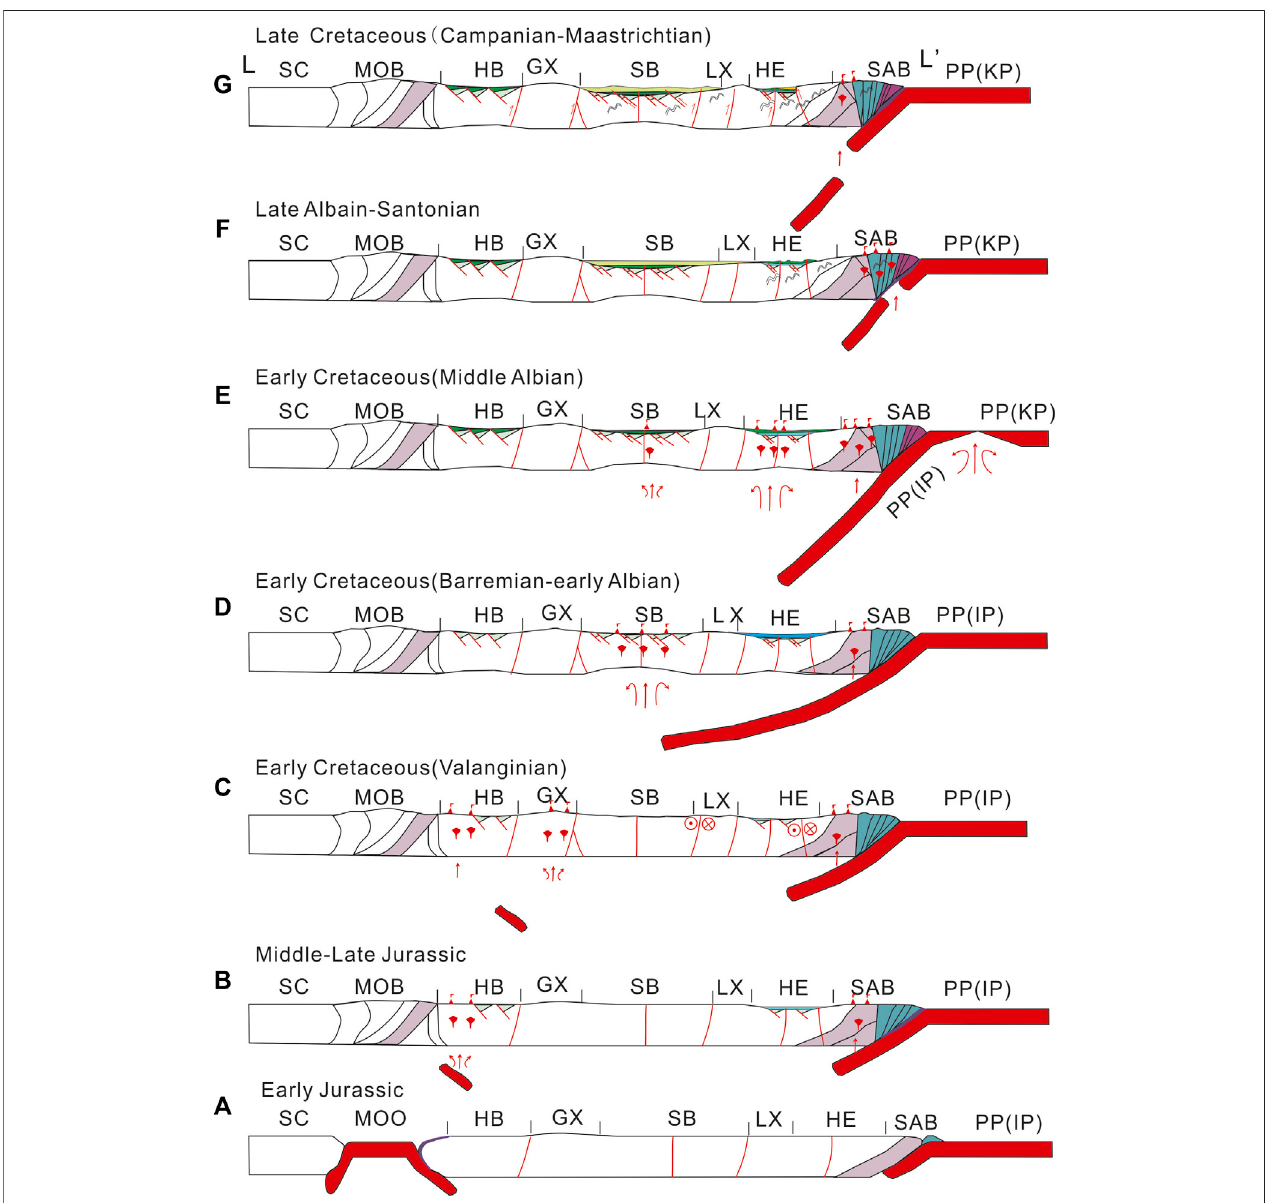
FIGURE 8 | The tectonic evolution of NE China and its geodynamic backgrounds during the Mesozoic era. It shows that two-sided active continental margin tectonics of the Mongolia – Okhotsk Belt suturing in the north, and the Paci fi c Plate subduction in the east controlled the evolution (Wang et al., 2016). It also shows the changes towards the increasing dominance of the Paci fi c Plate subduction (Li et al., 2012). Abbreviations: SC, siberian craton; MOO, mongolia – okhotsk ocean; MOB, mongolia – okhotsk orogenic belt; HL, hailer basin; GX, greater khingan range; SB, songliao basin; LX, lesser khingan range; HE, EHLJ; SAB, sikhote-alin orogenic belt, PP, paci fi c plate, also called Izanagi (180 – 85 Ma) and Kula (85 – 70 Ma) plates during the Cretaceous (Maruyama et al., 1997); IP, izanagi plate; KP, kula plate.